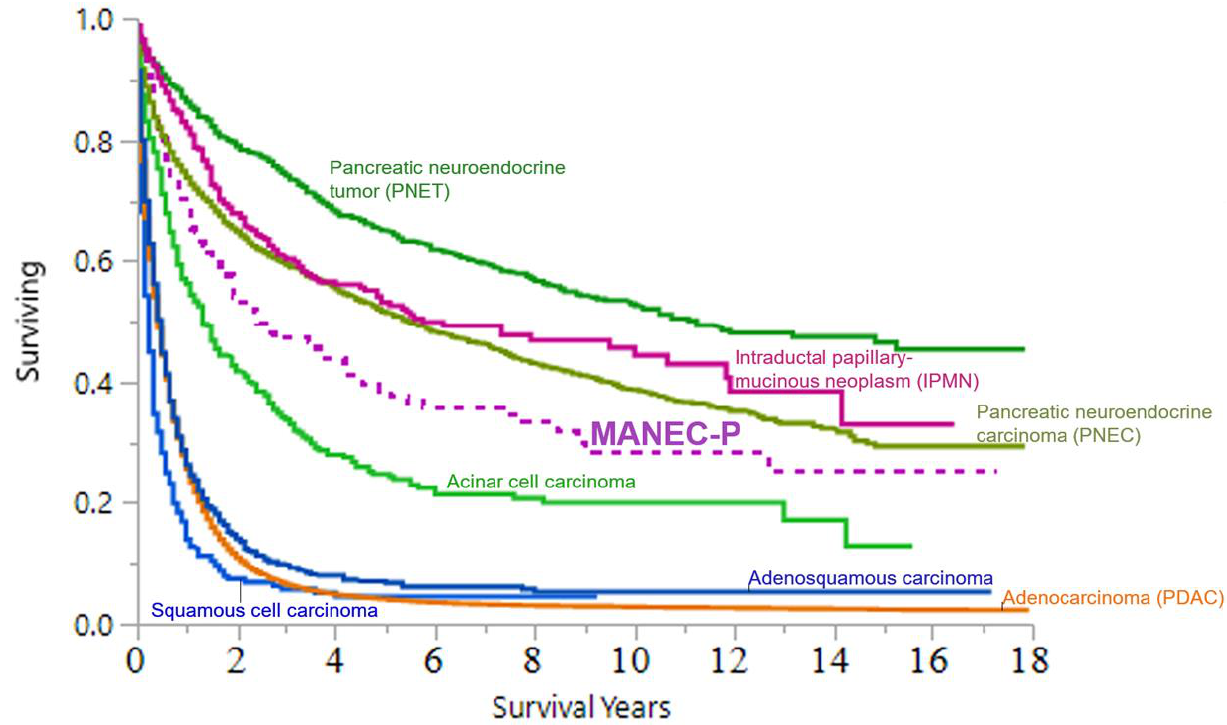
Figure 5. United States CSS over the time between 2001 and 2017 for MANEC-P patients compared with major pancreatic cancer histological subtypes.